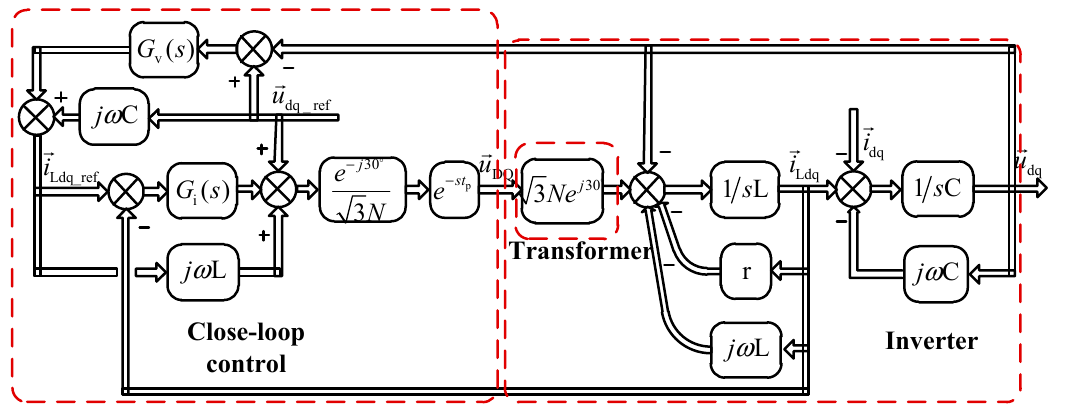
Figure 4. Voltage and current double-loop.